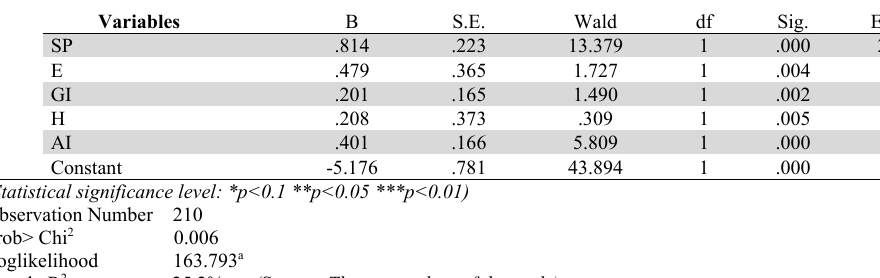
Results for binary logistic regression model